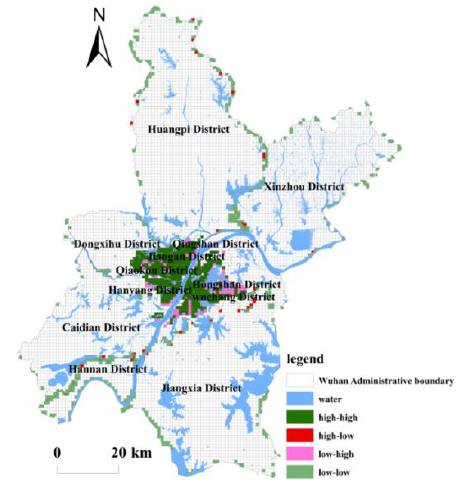
Figure . 4 Evaluation result at the local scale